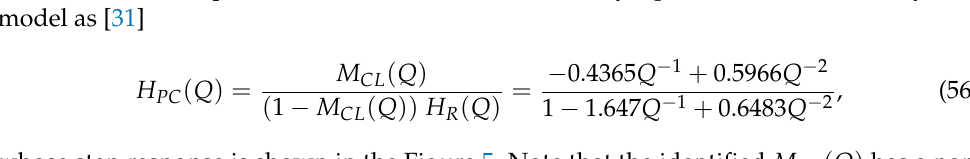
Figure 5. The step response of 𝐻 𝑃𝐶 (𝑞) [31].